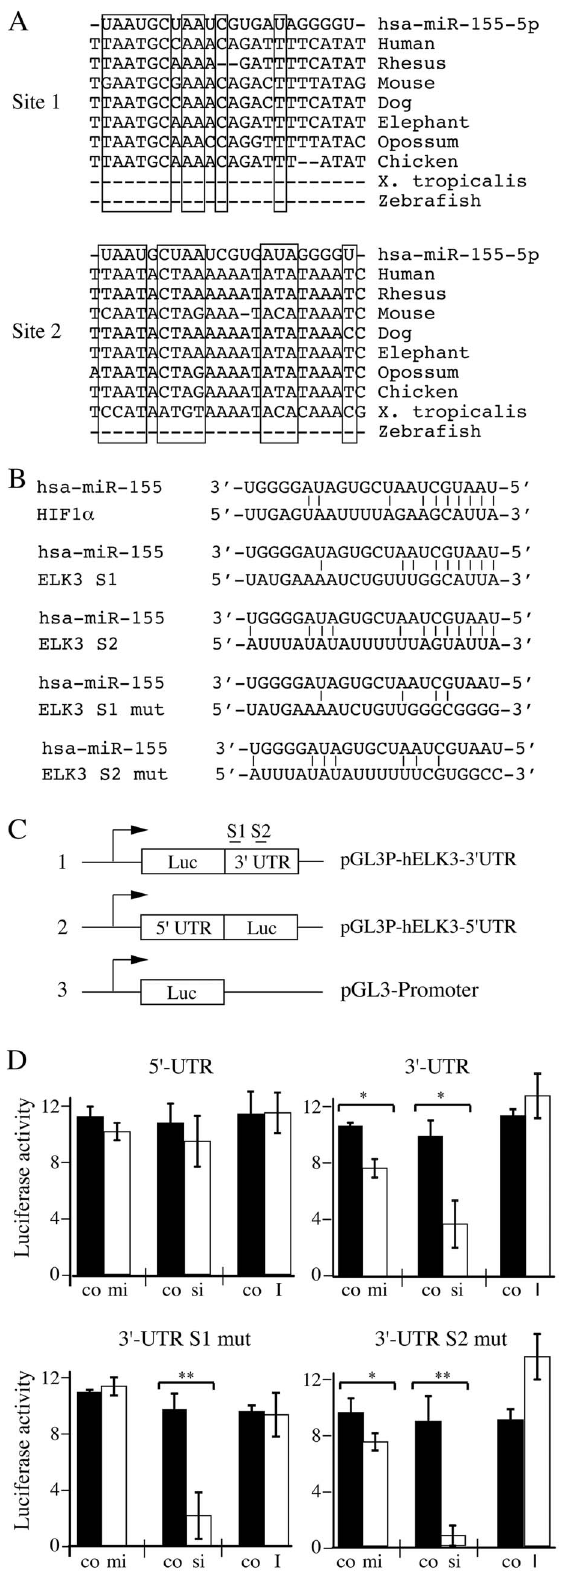
Figure 3. Identification of hsa-miR-155-5p target sites on the ELK3 3 9 -UTR. (A) Homology between hsa-miR-155-5p and two sequences (S1 & S2) in the human ELK3 gene and conservation